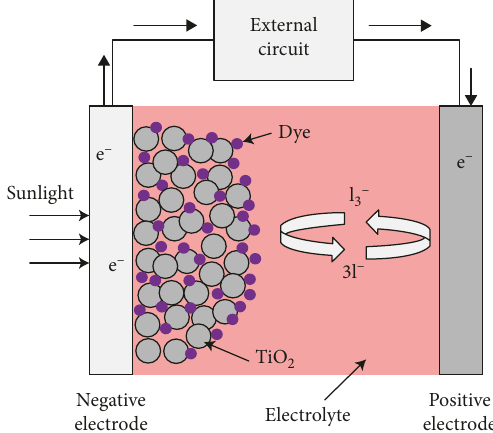
Figure 1: General operation principle of